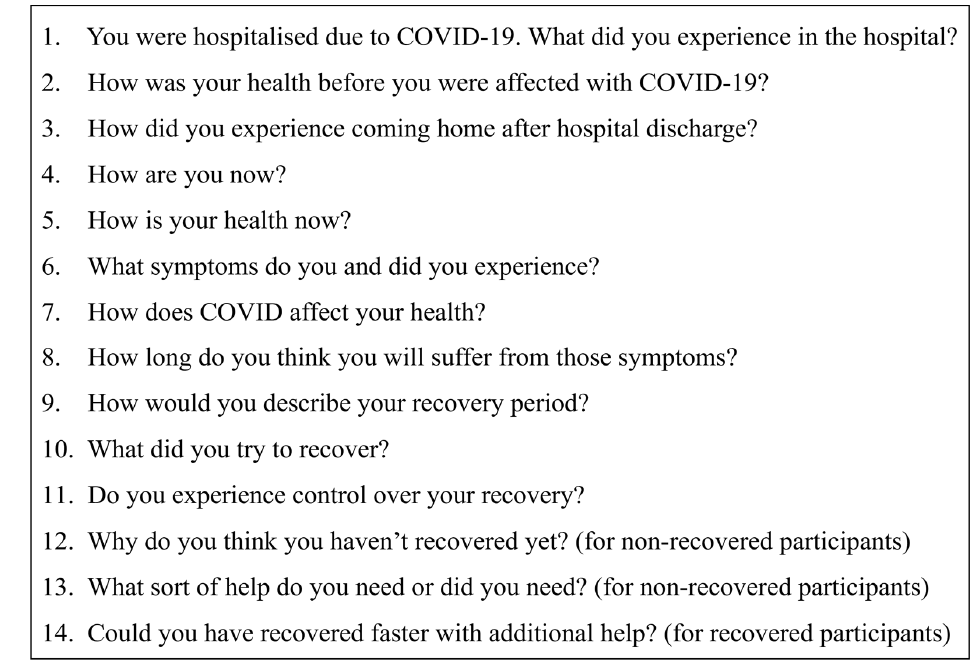
Figure 2. Interview guide.